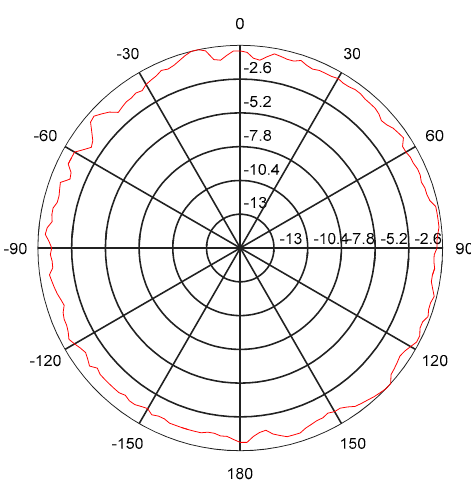
Figure 16. The directivity curve of transducer in the water. Table 7. Comparison of the parameters of the transducer designed in this paper with other advanced transducers.